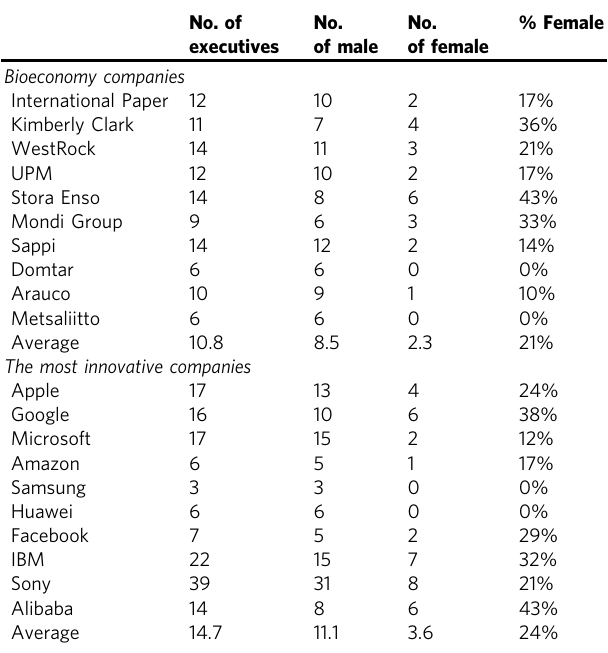
Table 5 Age diversity in the bioeconomy and the most innovative company